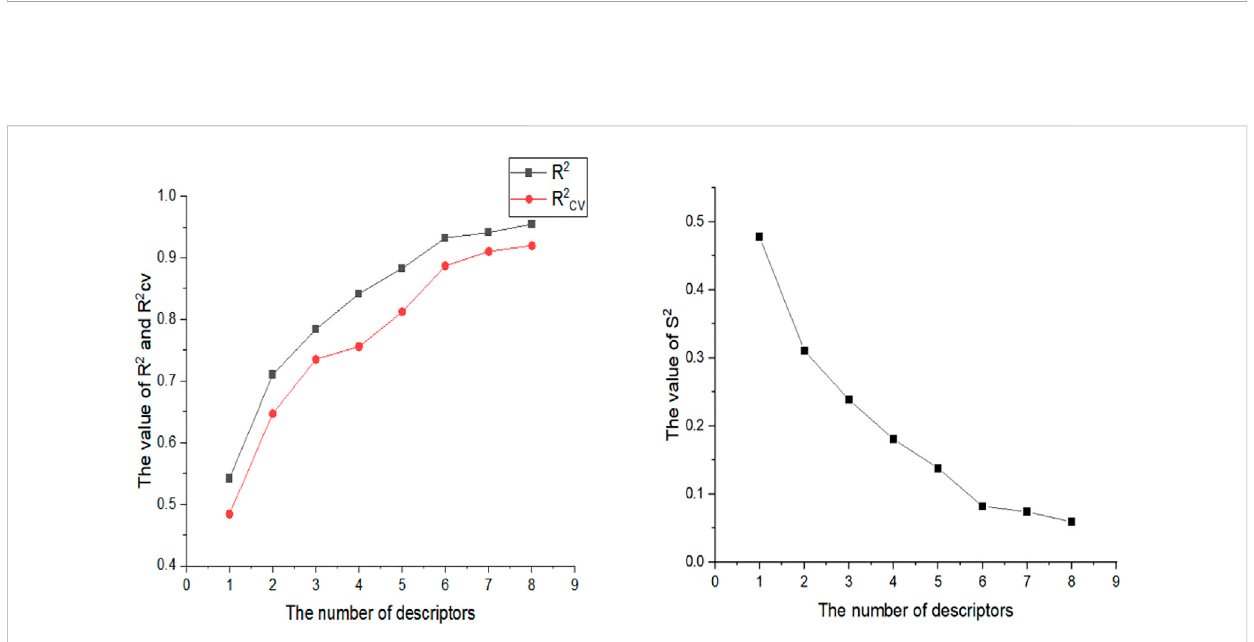
FIGURE 3 The effects of different numbers of descriptors on R 2 , R 2 cv and S 2